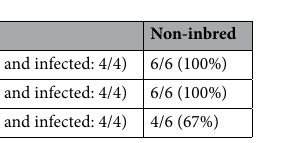
Figure 4. Individual distribution patterns of melanophore spots of six young non-inbred medaka at two consecutive time points. Distribution patterns at the first ( a ) and second ( b ) time point, separated by four weeks. A number is utilized as an individual identifier in each image. The Kyoto-Cab strain was used as non-inbred medaka. Individuals #38, #40, and #41 were male, and Individuals ##37, #39, and #42 were female. R-C: rostral- caudal axis, L-R: left–right axis.